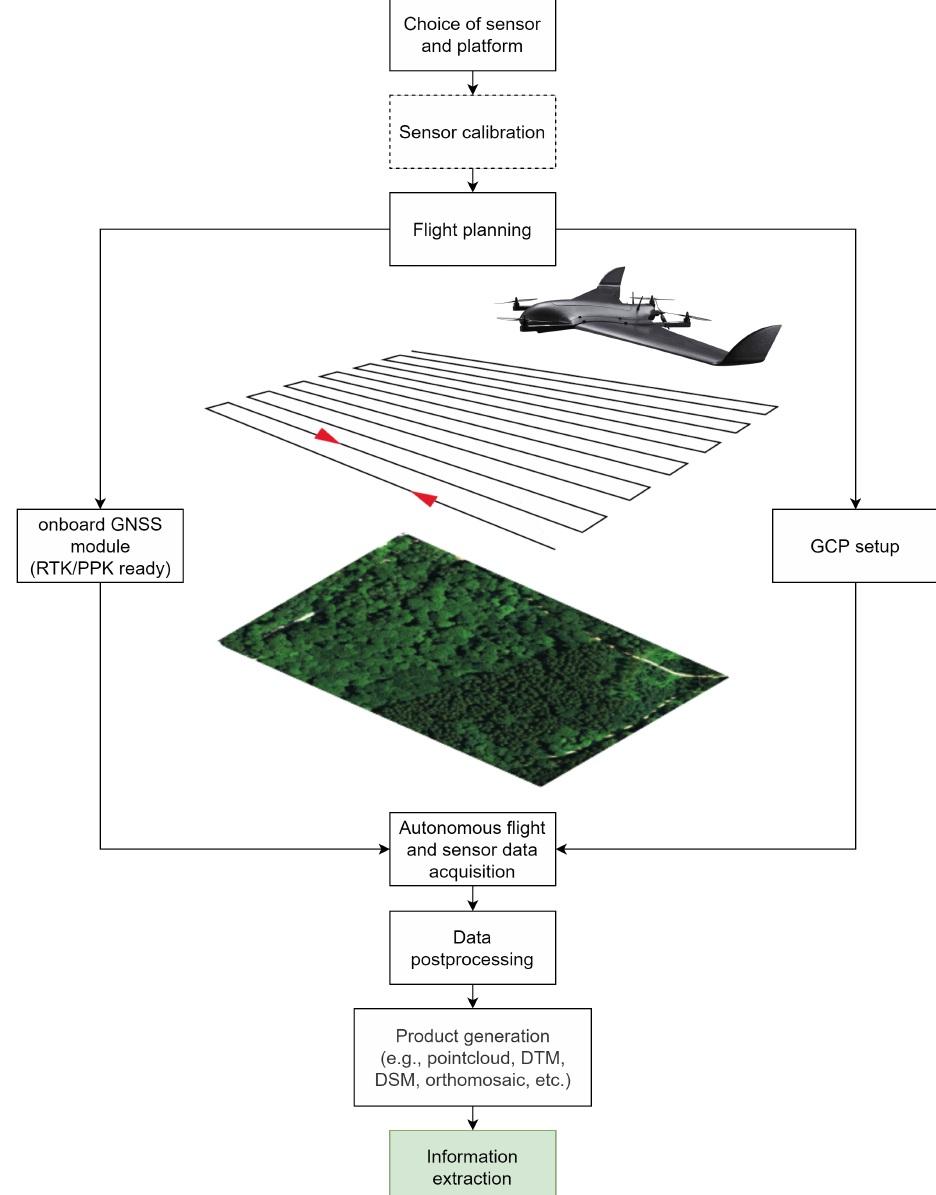
Figure 2. General workflow of UAV-based data acquisition and processing